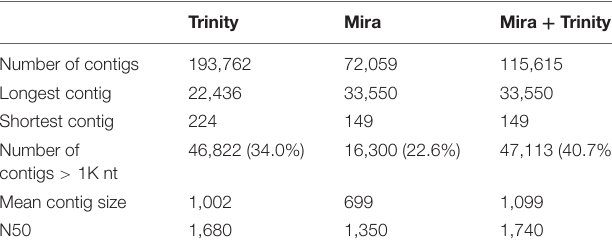
TABLE 1 | Assembly